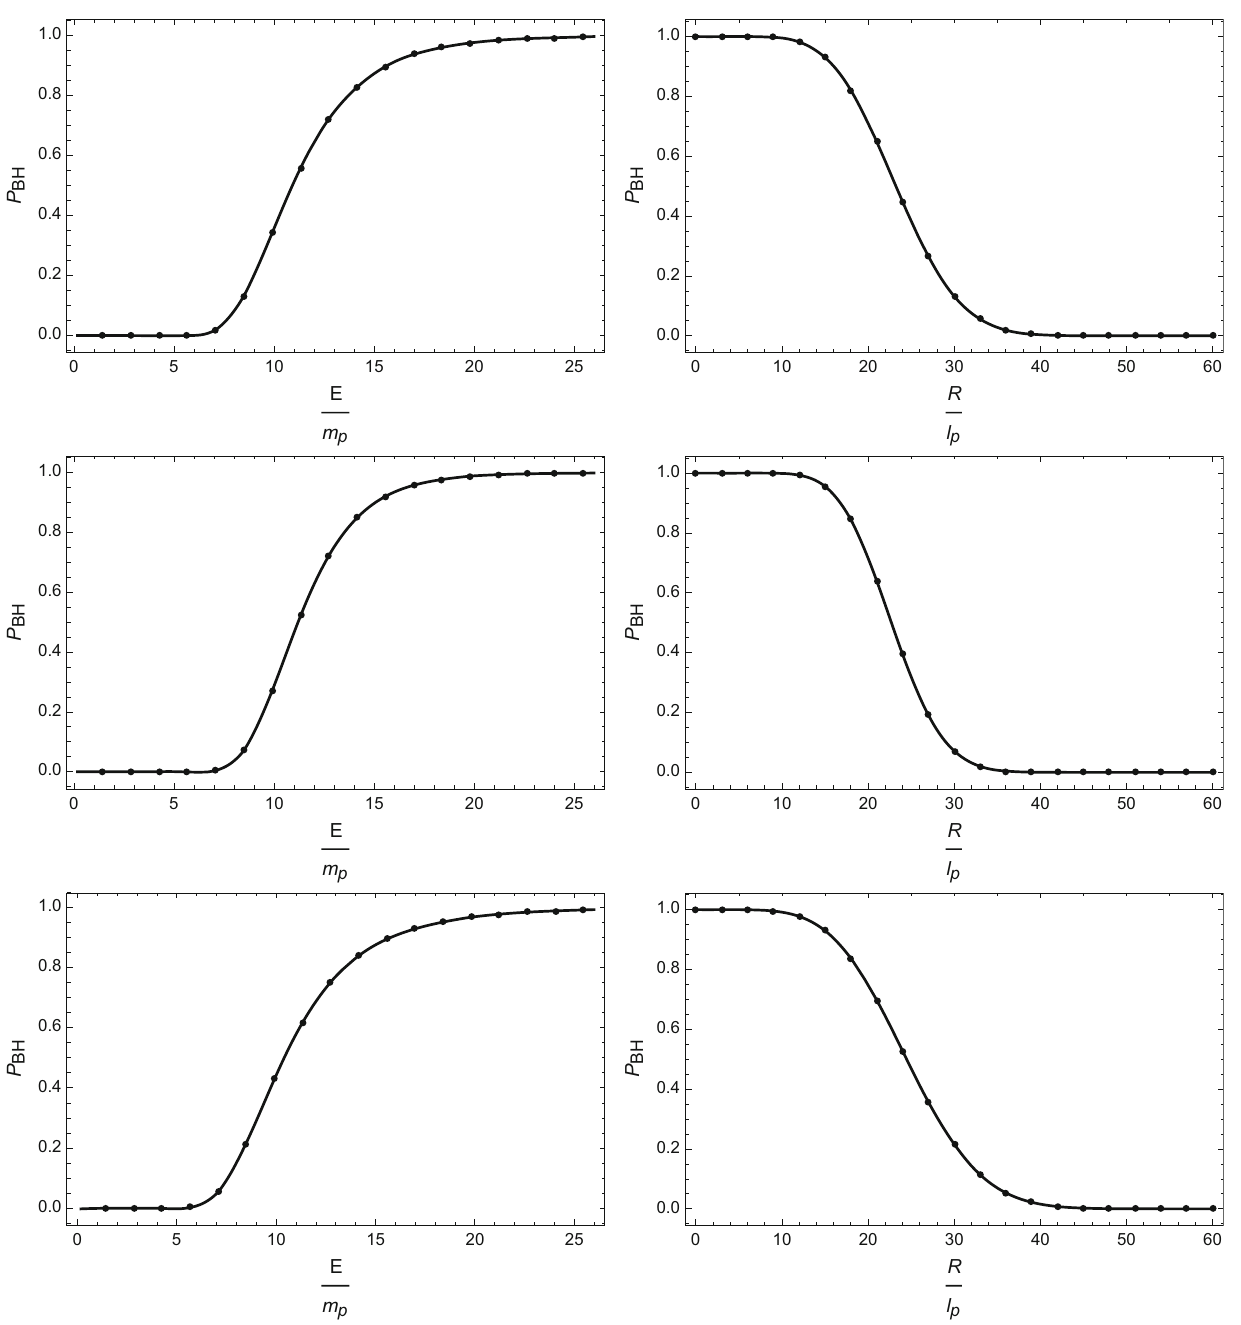
Fig. 7 Top left:Probability P BH forthesystemoftwocollapsingshells P BH as a function of the mean radius R for P 1 = 3 m p , P 2 = 3 m p √ with P 1 = 5 P 2 to be a black hole as a function of the total energy of the and E = 6 2 m p . Bottom left: P BH for a single collapsing shell as twoshellsfor R = 30 (cid:2) p .Top right: P BH asafunctionofthemeanradius a function of the energy of the shell for a mean radius R = 30 (cid:2) p . √ Bottom right: P BH for a single shell as a function of the mean radius R R for P 1 = 5 m p , P 2 = m p and E = 6 2 m p (cid:11) 8 . 5 m p . Middle left: √ P BH for the system of two collapsing shells with P 1 = P 2 as a func- 2 m for P = 6 m p and E = 6 tion of the total energy of the two shells for R = 30 (cid:2) p . Middle right: